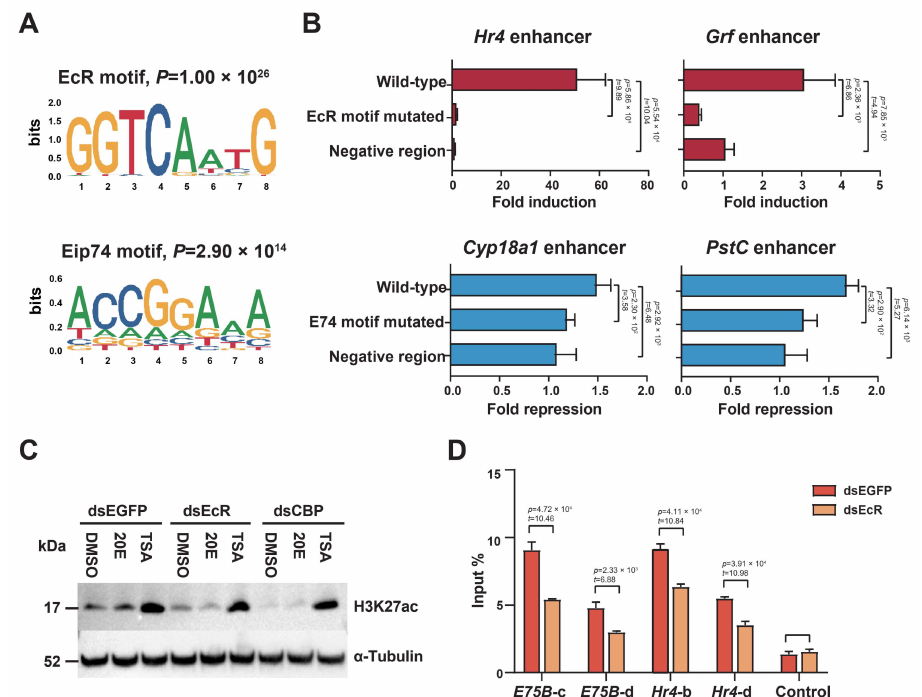
Figure 4. Ecdysone receptor (EcR) played a critical role in inducing enhancer activity. ( A ) Upper and lower panels: de novo motif analysis of enhancers with increasing or decreasing H3K27 acetylation, respectively. The most enriched motif is shown. ( B ) Luciferase assays for the enhancer categories in DMSO- or 20E-treated BmE cells. Fold induction of the normalized luciferase signal for the H3K27 acetylation-increasing enhancers near Hr4 and Grf assessing wild-type sequences and EcR-motif- mutated variants. Fold repression of normalized luciferase signal for H3K27 acetylation-decreasing enhancers near Cyp18a1 and PstC assessing wild-type and Eip74-motif-mutated variants, in which the enhancer did not contain an EcR motif. Negative region: sequence from the Hr4 control region, as in Figure 1E. The DNA sequences are listed in Supplementary Table S2. Student’s t -test (df = 4). ( C ) Western blotting of protein extracts of BmE cells first treated with dsRNA against EGFP, EcR, or CBP, then either left untreated or exposed to 20E or TSA for 12 h. The antibodies used are shown on the right. ( D ) ChIP-qPCR of H3K27 acetylation in BmE cells treated with dsRNA against EGFP or EcR. DNA was quantified using primers designed to amplify the enhancer regions of E75B and Hr4 gene loci, as shown in Figure 1C,E. Error bars: standard error of the mean (SEM) from three biological replicates measured in duplicate. Student’s t -test (df =